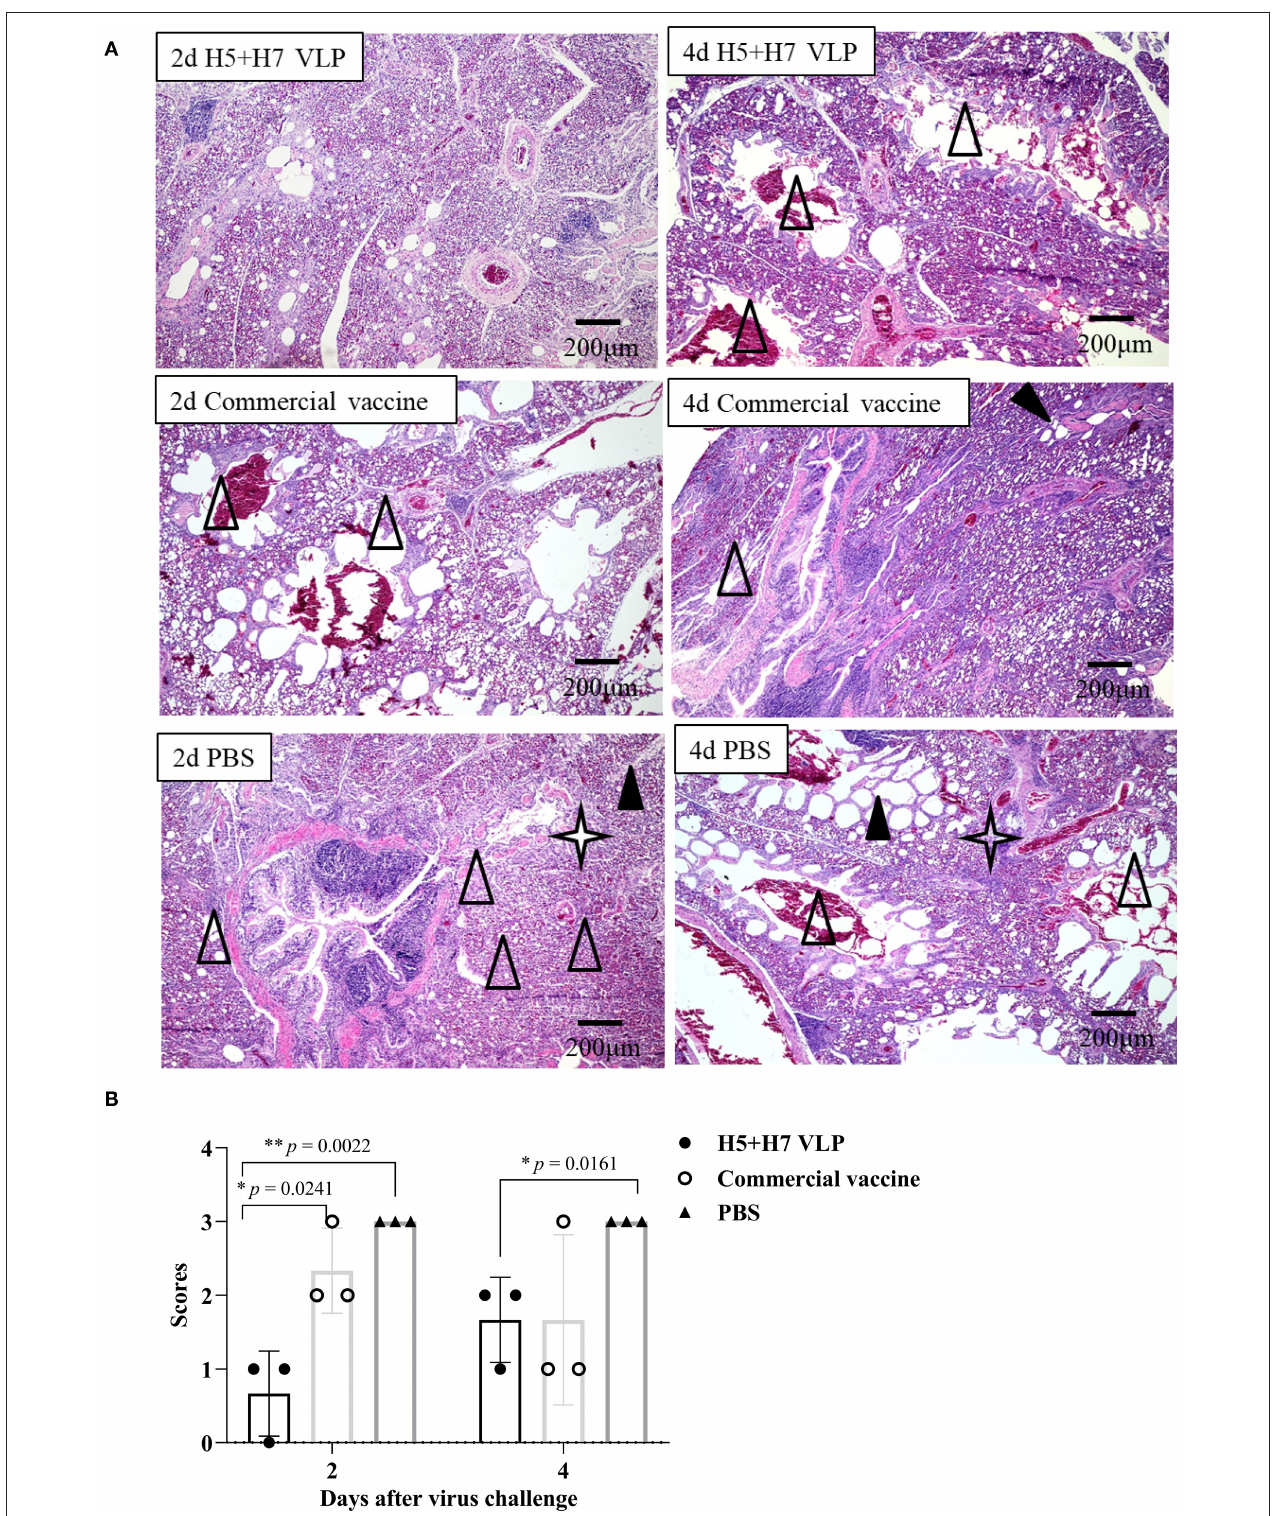
FIGURE 7 | The bivalent H5 + H7 VLP vaccine alleviates lung injury after the lethal H7N9 virus challenge. (A) H & E staining results of the bird’s lung on Day 2 and 4 post-H7N9 virus challenge. Black triangle indicates dilatation in the pulmonary chamber or bronchial; white triangle arrow stands for infiltration of fiber cells, detached epithelial cell mucus, and erythrocytes in the parabrochus; quad star means lymphocytes infiltration in the lung chamber. (B) Scores of the overall histopathologic changes in the bird’s lung post-H7N9 virus challenge. The specific information concerning the scoring criteria was listed in the Materials and Method section.